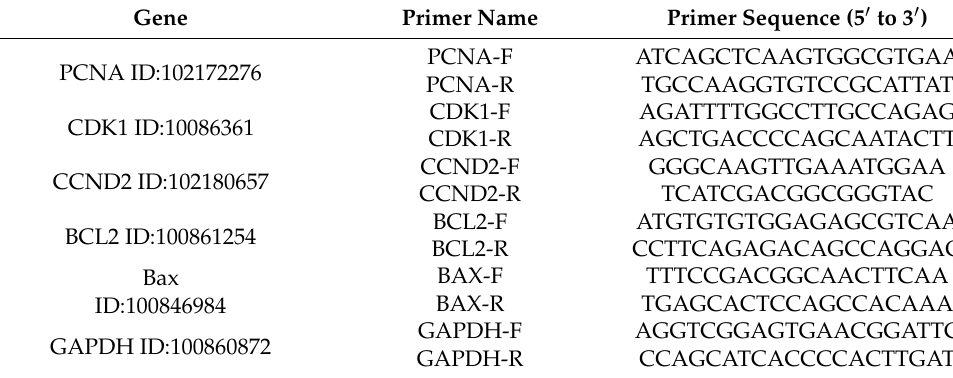
Table 1. Primer information for quantitative reverse transcription.